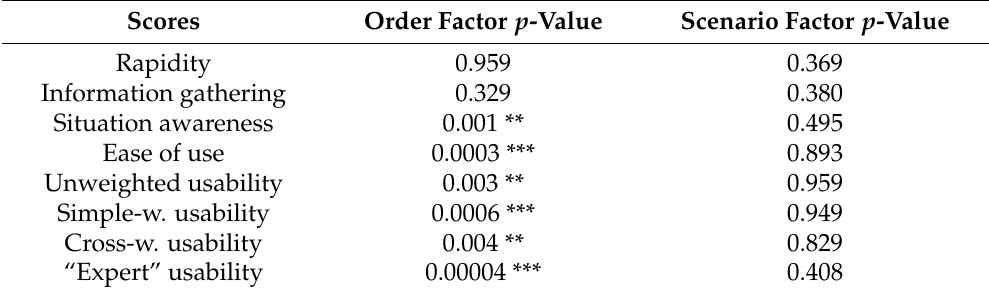
Table 2. Desktop application: repeated-measures ANOVA on quality factors and usability scores with interaction technique, scenario, and order factors.